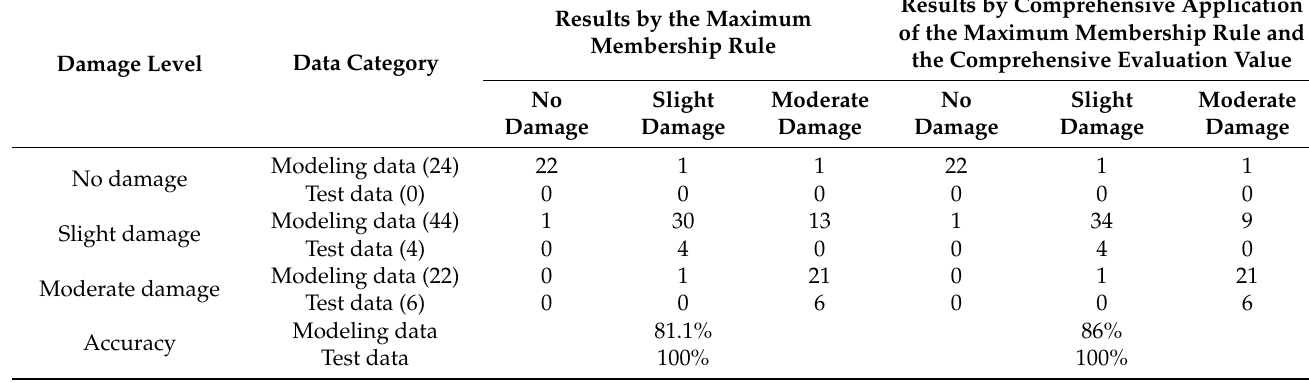
Table 9. Accuracy of the tunnel damage level by using different methods.